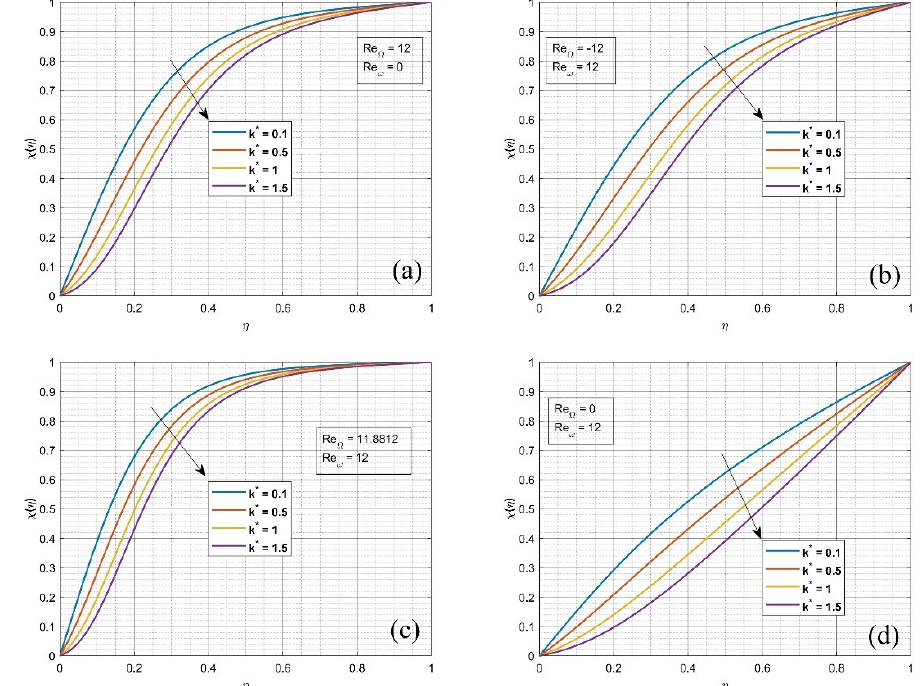
Figure 5. ( a – d ): Influence of thermophoretic co-efficient on χ ( η ) ; ( a ) is the scenario between a rotating cone and stationary disk; ( b ) the scenario between a counter-rotating cone; ( c ) the scenario between a rotating disk and a stationary cone; ( d ) the scenario between a co-rotating cone and disk.